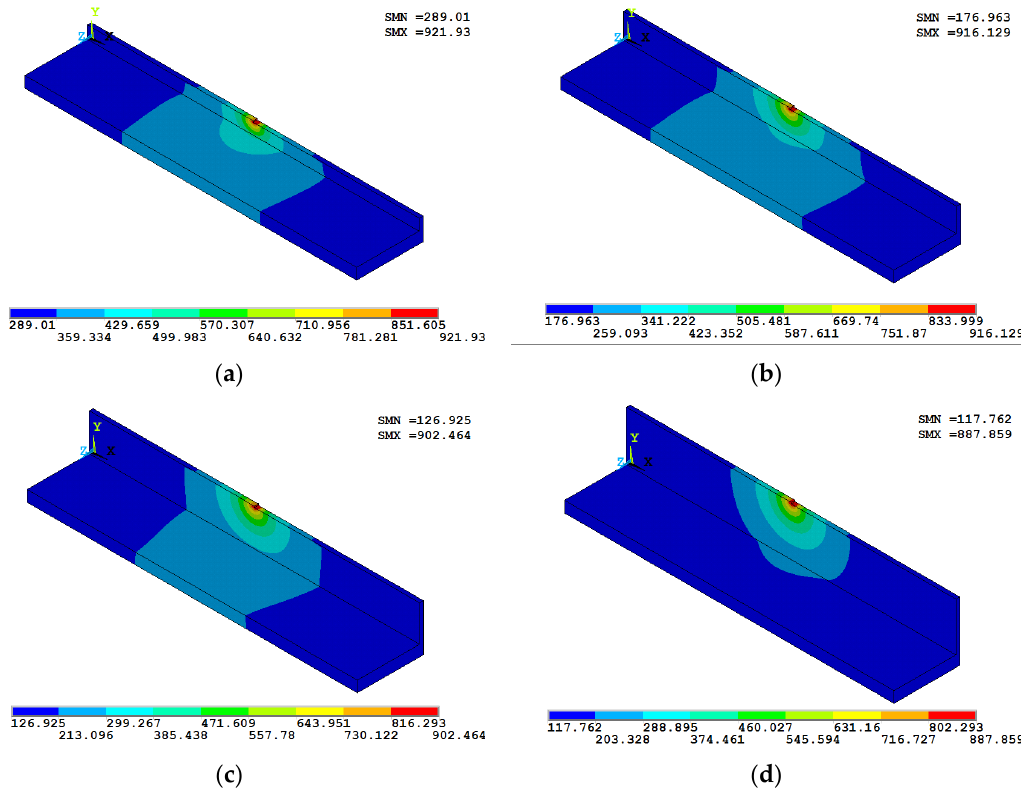
Figure 8. Temperature profile of ( a ) 10th layer, ( b ) 20th layer, ( c ) 30th layer and ( d ) 40th layer when the weld gun travels to each layer midpoint.